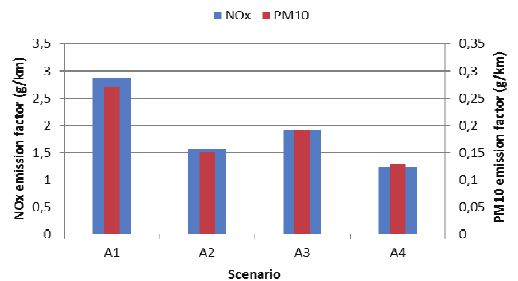
Fig.12. Emission factors for NO x and PM10 for considered scenarios